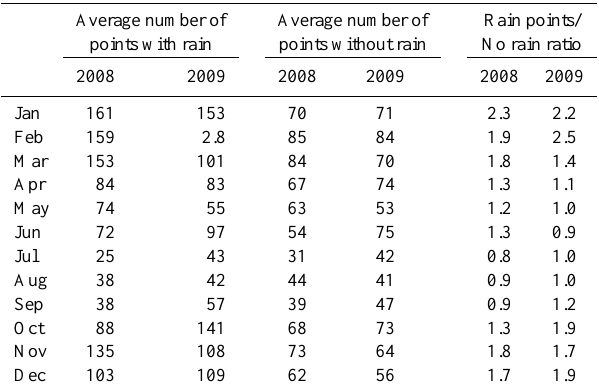
Table 1. Number of grid boxes with and without rainfall for 2008 and 2009. Average number of Average number of Rain points/ points with rain points without